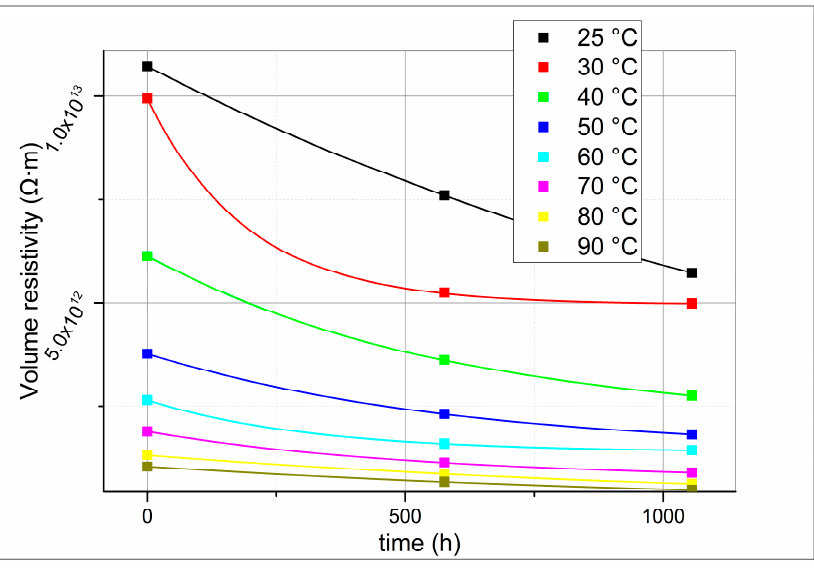
Figure 6. Time dependency of the resistivity of sunflower oil at 140 °C exposure.